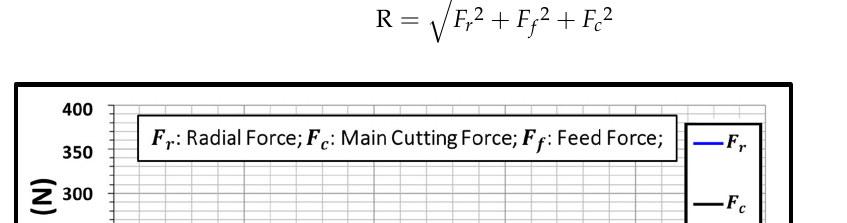
Table 4. ThermoPro-TP8 specifications.